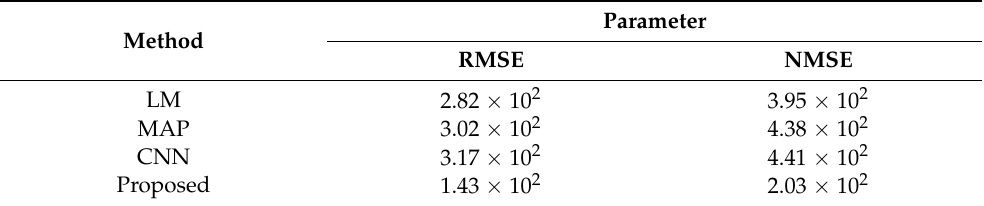
Table 2. RMSEs and NMSEs of the reconstruction results of four methods.